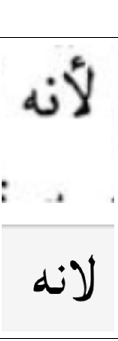
Figure 18: Missed hamza.